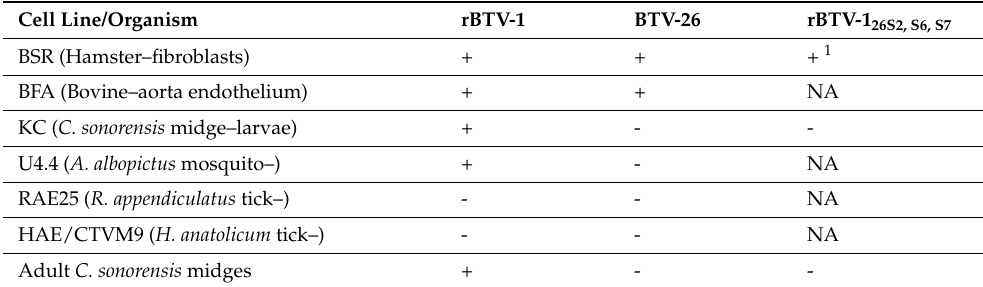
Table 3. Summary of the ability of rBTV-1 and BTV-26 to replicate in several mammalian and arthropod-derived cell